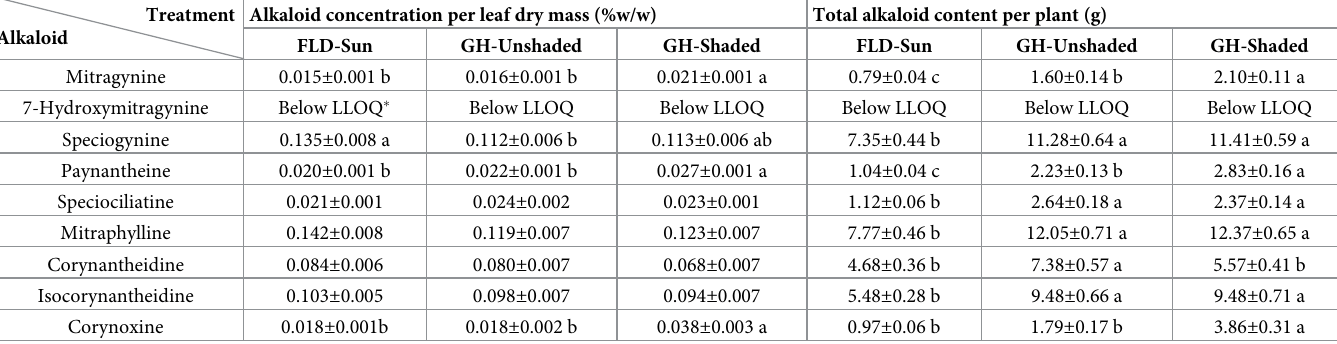
at P < 0 . 05 . � LLOQ = Lower Limit of Quantification